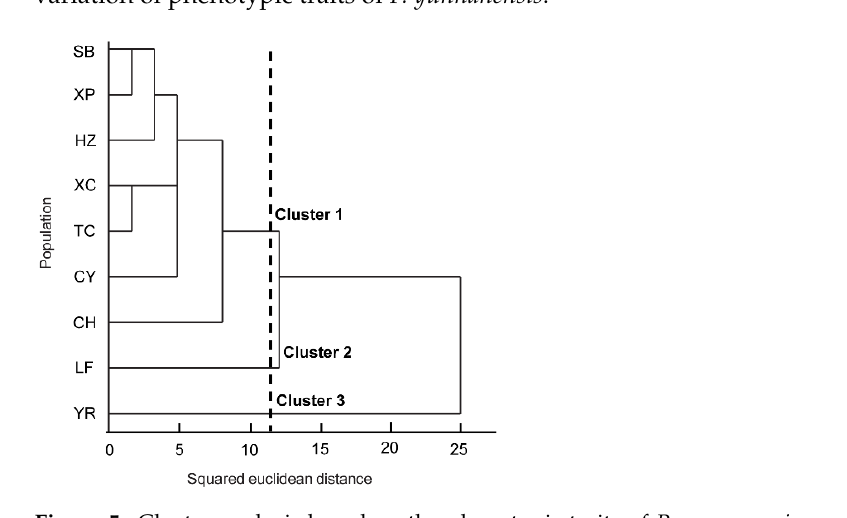
Figure 5. Cluster analysis based on the phenotypic traits of P. yunnanensis populations. Table 1 indicated the number of populations. Population abbreviations are shown in Table 1.